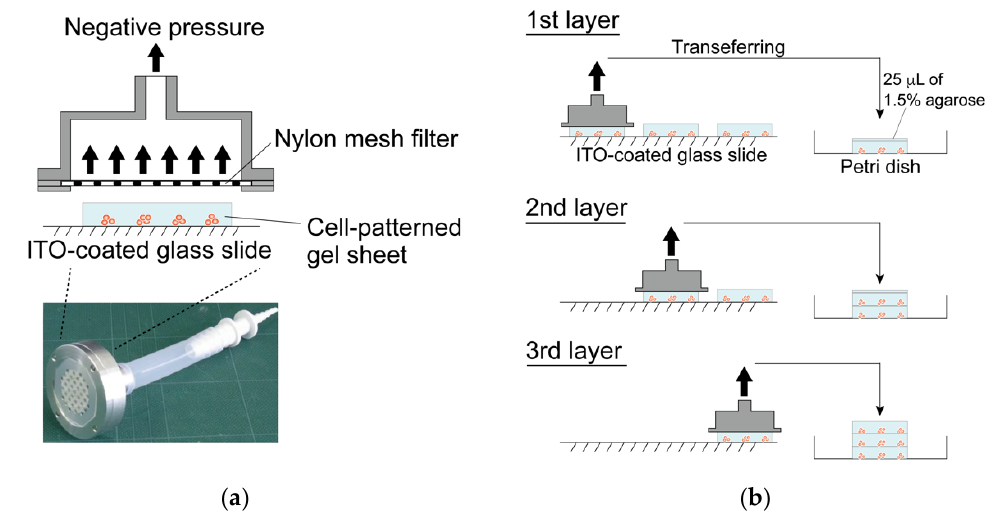
Figure 4. Fabrication of the layered gel-sheet construct. ( a ) Gel sheet transferring device using negative air pressure and ( b ) layering process of the cell-patterned agarose gel sheets.